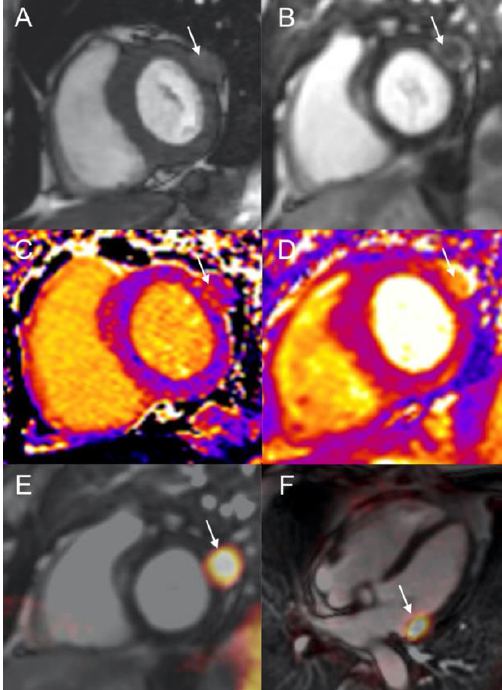
Figure 3. Patient 2. CMR showing a NEN metastasis of lateral basal LV wall (arrows) appearing as 25-mm nodule with intermediate intensity on SSFP T1-weighted images ( A ), with peripheral